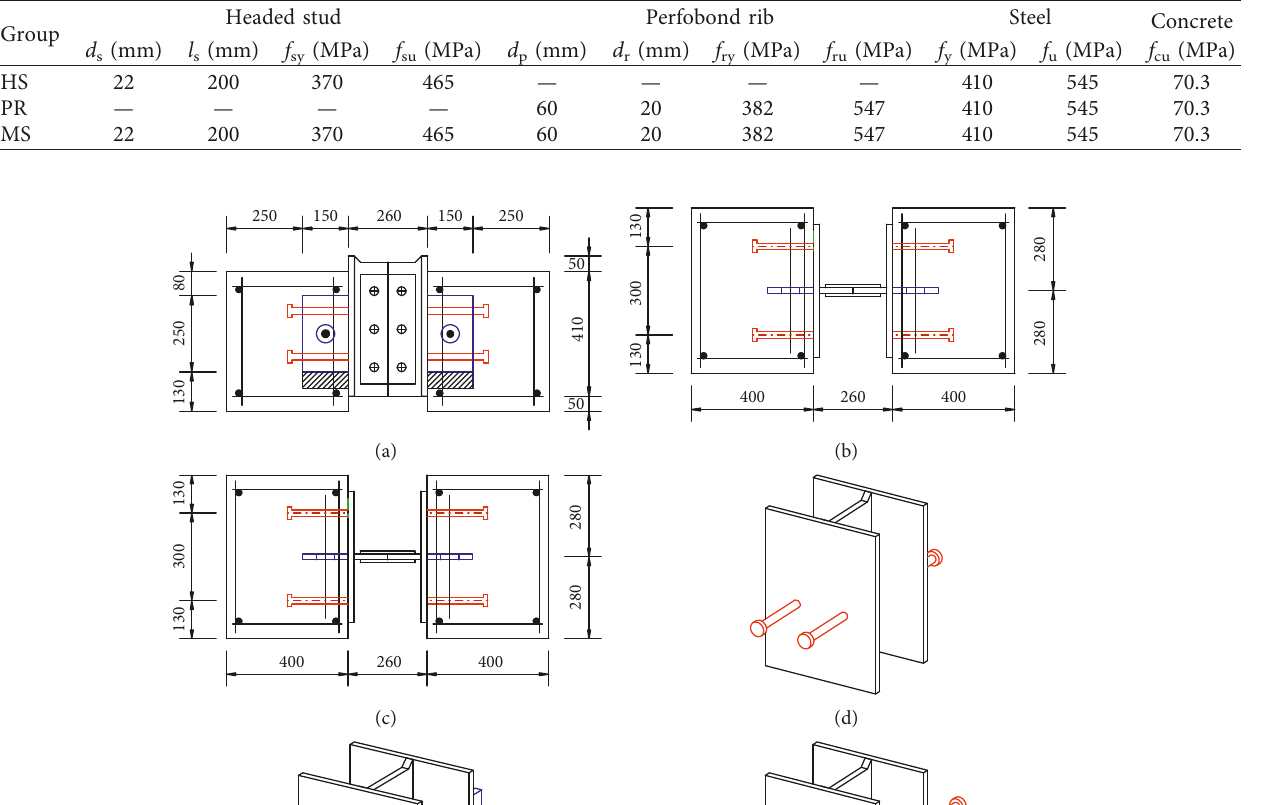
Table 1: Push-out test specimens.